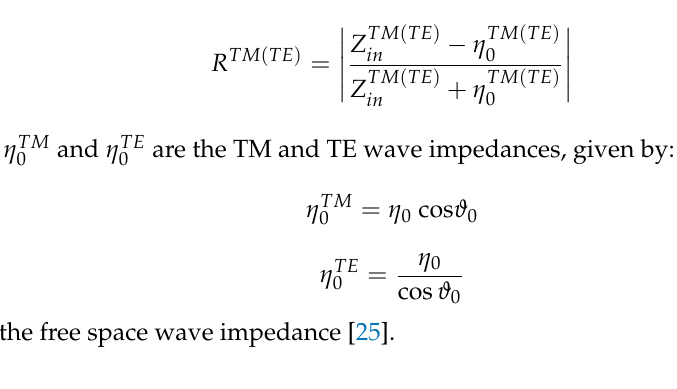
Figure 2. Frequency spectra of the real ( a ) and imaginary ( b ) parts of the permittivity of the graphene based composite employing different amounts of GNPs.